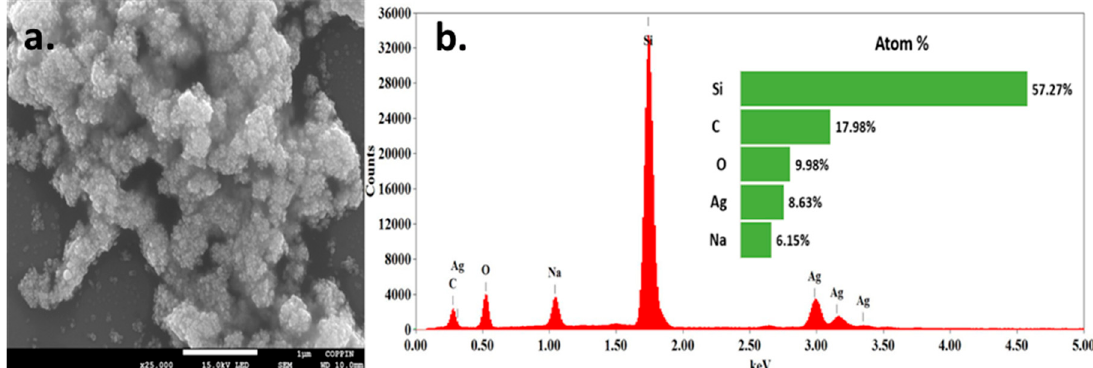
Figure 3. Field emission scanning electron microscopy imaging ( a ) and the corresponding energy dispersive x-ray spectroscopy ( b ) of the synthesized silver nanoparticles.